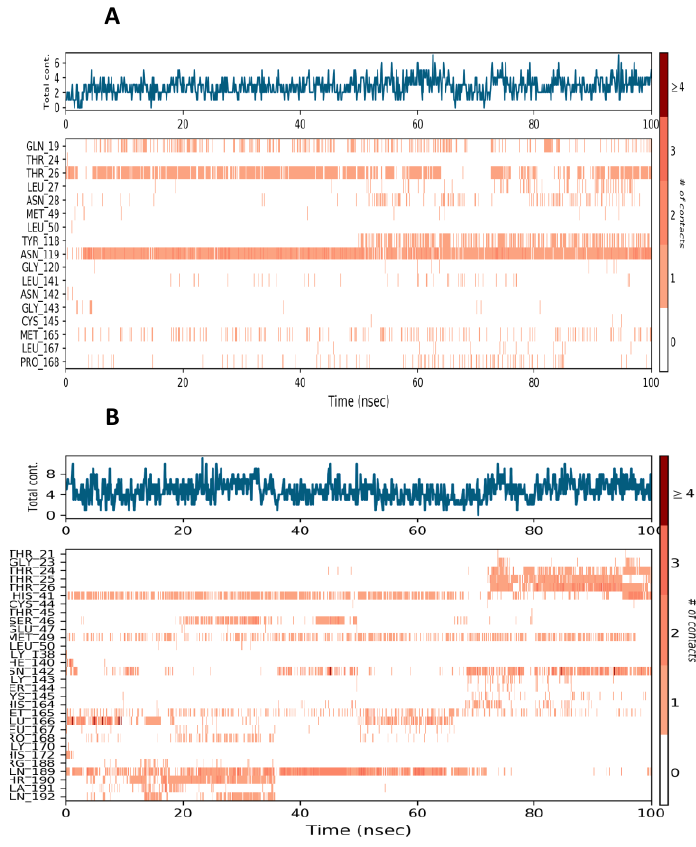
Figure 5. Protein-ligand interaction ( A ) Mpro-Lopinavir contacts at 30% consistency ( B ) Mpro-25-hydroxy vitamin D contacts at 30% consistency.